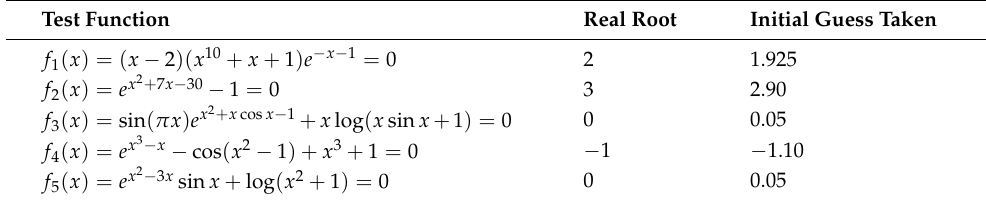
Table 1. Test functions along with their roots and initial guesses taken. Test Function Real